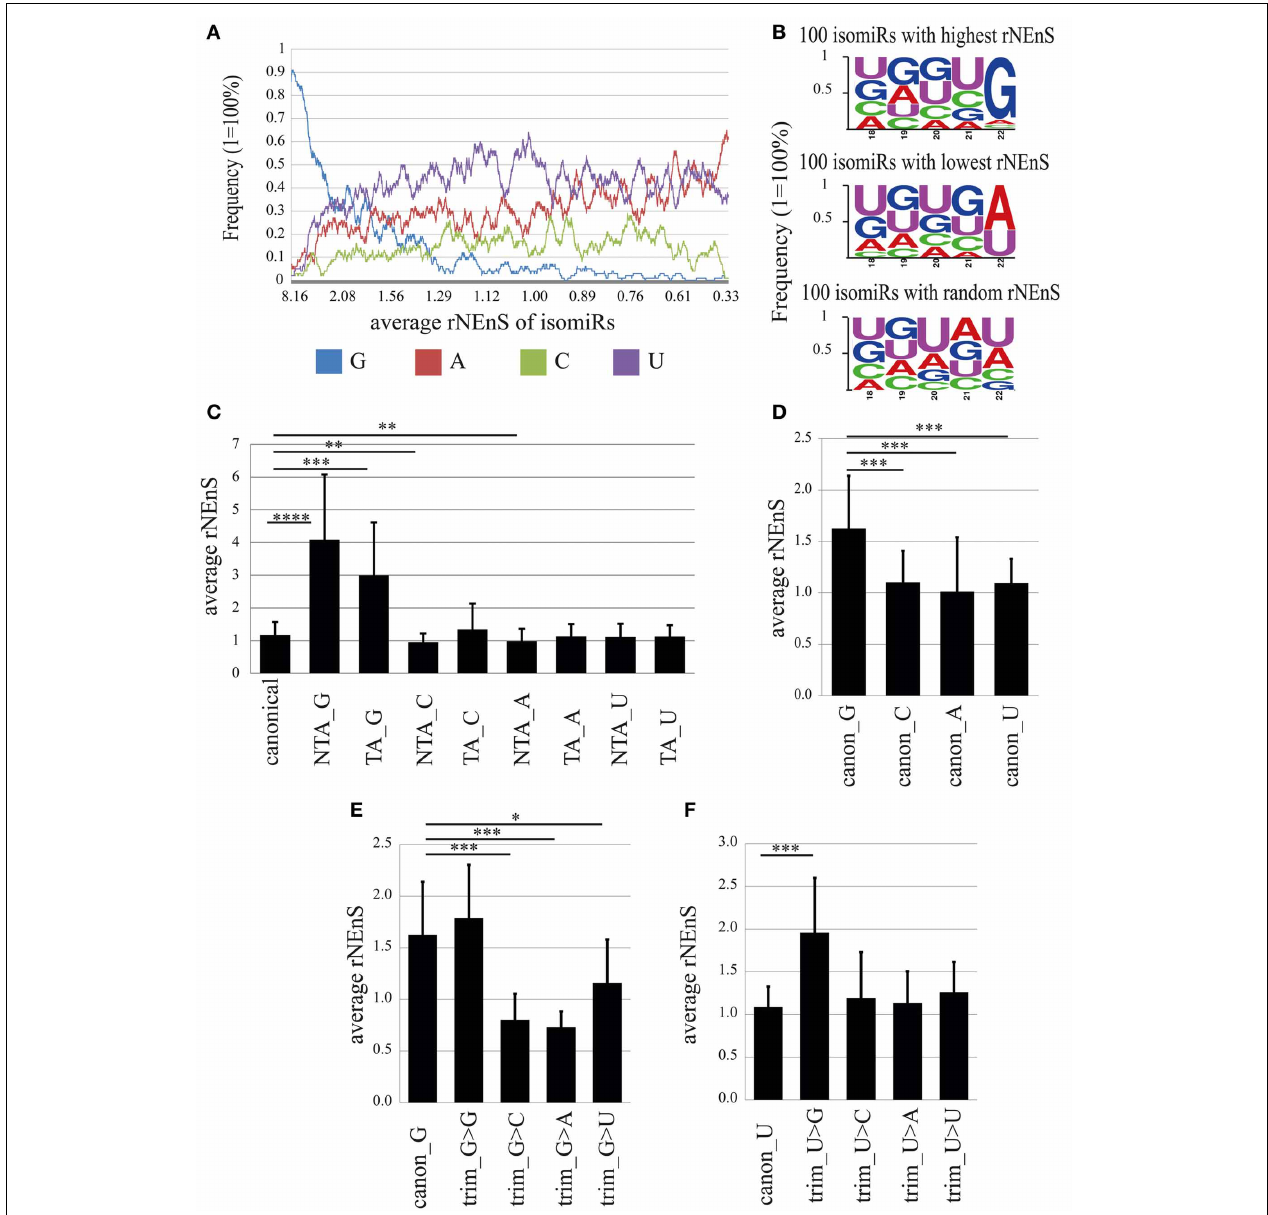
containing different 3 (cid:2) -terminal nucleotides. Bar plots show mean ± SD (canon_G, n = 57; canon_C, n = 62; canon_A, n = 75; canon_U, n = 112). Statistical significance was determined using Welch (cid:2) s t -test (unequal variance) with Bonferroni correction ( ∗ p < 0 . 05; ∗∗ p < 0 . 001; ∗∗∗ p < 1 . 0-E7). (E,F) Impact of trimming on the nuclear localization of isomiRs. (E) rNEnS for canonical isomiR_G that underwent 3 (cid:2) trimming, thereby exposing the indicated nucleotide. Bar plots show mean ± SD (canon_G, n = 57; trim_G > G, n = 12; trim_G > C, n = 14; trim_G > A, n = 17; trim_G > U, n = 9). Statistical significance was determined using Welch (cid:2) s t -test (unequal variance) with Bonferroni correction ( ∗ p < 0 . 05; ∗∗ p < 0 . 001; ∗∗∗ p < 1 . 0-E5). (F) rNEnS for canonical isomiR_U that underwent 3 (cid:2) trimming, thereby exposing the indicated nucleotide. Bar plots show mean ± SD (canon_U, n = 112; trim_U > G, n = 32; trim_U > C, n = 29; trim_U > A, n = 10; trim_U > U, n = 20). Statistical significance was determined using Welch (cid:2) s t -test (unequal variance) with Bonferroni correction ( ∗ p < 0 . 05; ∗∗ p < 0 . 001; ∗∗∗ p < 1 .